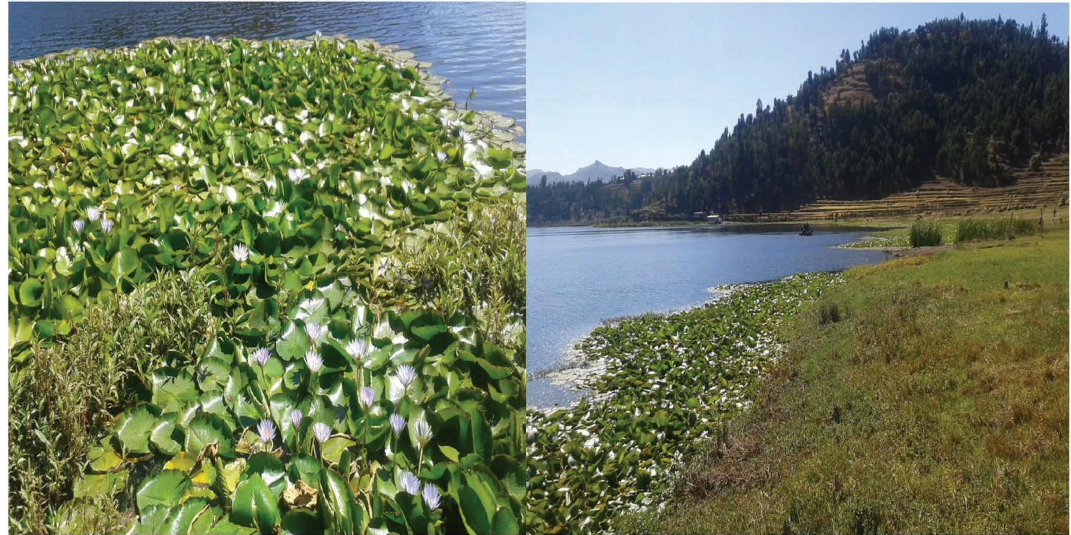
Figure 4: Excessive growth of water lily, Lake Maybar, South Wollo (source: own